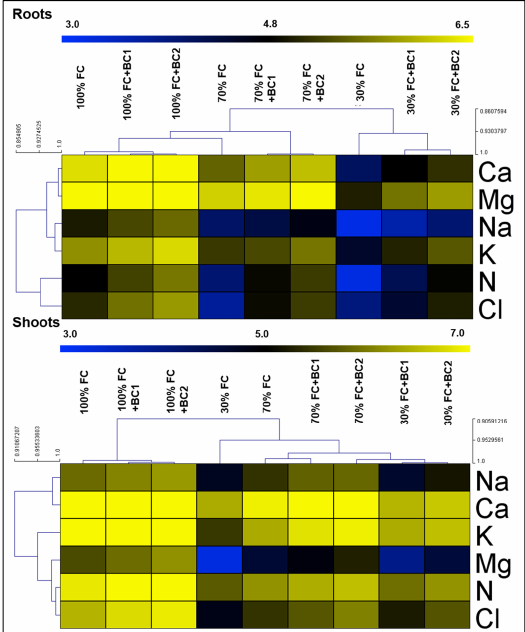
Figure 3. Biochar-induced improvement in the nutrient uptake of drought-stressed L. fusca plants. FC, BC, Na + , Ca 2+ , K + , Mg 2+ , NO 3 − , and Cl − refer to field capacity, biochar, sodium, calcium, potassium, magnesium, nitrate, and chloride, respectively. The heatmaps were developed by Multiviewer Experiment software by using log-2 values.